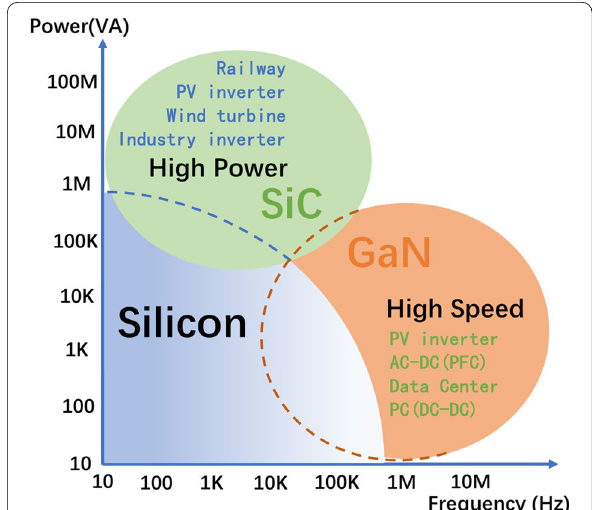
Fig. 1 Potential applications of GaN and SiC power